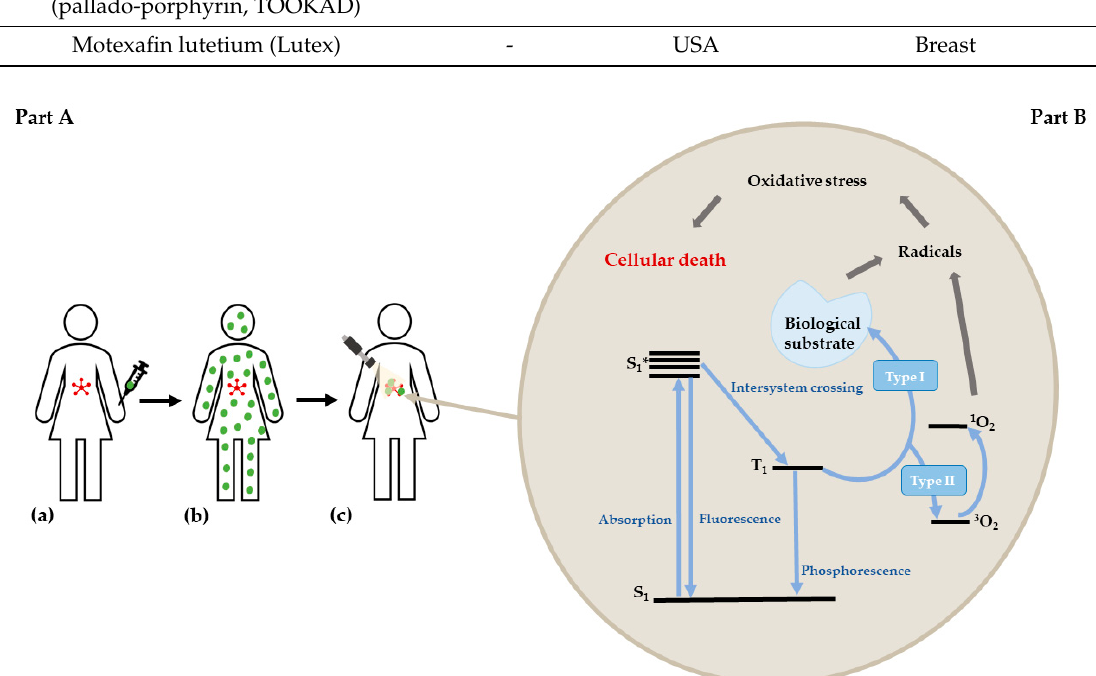
Figure 1. A —Standard PDT treatment: administration of PS ( a ) systemic PS distribution into the body; ( b ) PS accumulation in the tumor and irradiation ( c ); B —Jablonski diagram describing the PDT process.